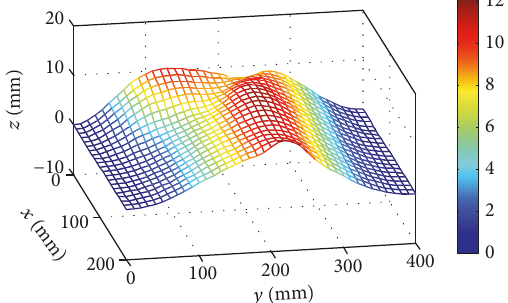
Figure 8: Initial shape without control.